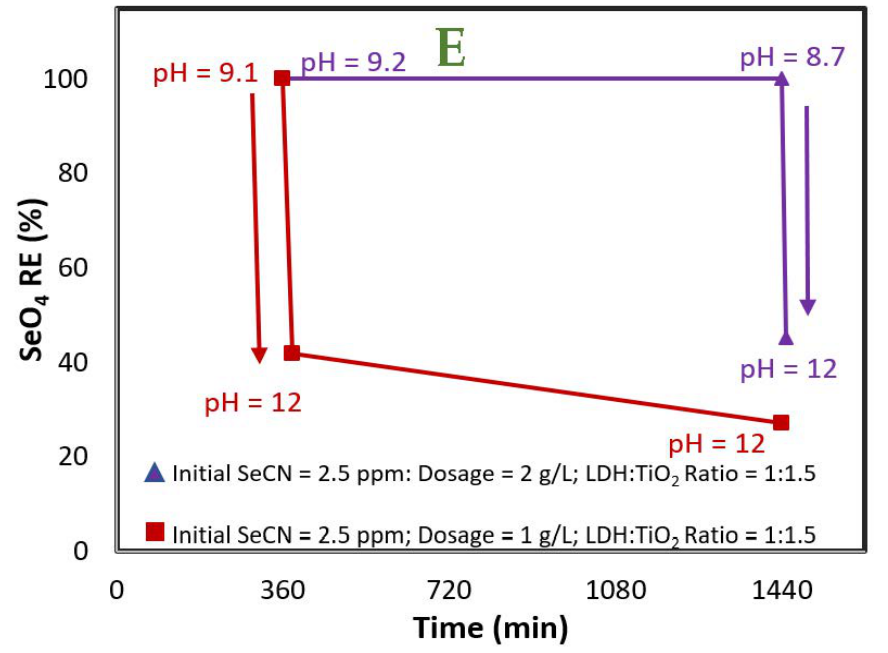
Figure 6. ( A – D ) PCD profile of SeCN − under different operating conditions; ( E ) pH influence on percentage of SeO 42 − adsorption (RE (%)).